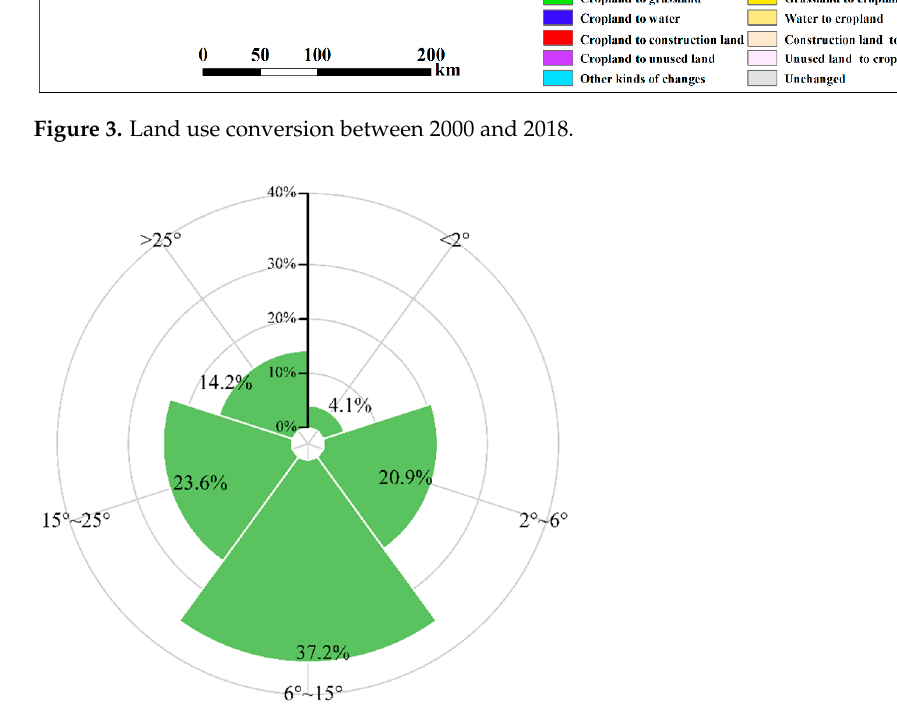
p=0.270y Figure 5. Mean value of NDVI ( a ) and global Moran’s I ( b ) between 2000 and 2018. As 2008 was a key time point for the vegetation change trend, the local Moran’s I of the vegetation was further analyzed for the years 2000, 2008, and 2018. High positive val- ues of the local Moran’s I were mostly concentrated around Wuhan and in the west of Hubei Province (Figure 6a–c), indicating that the NDVI values in these places were similar to those of their neighbors. The areas with a positive local Moran’s I moved to the north- west in Hubei Province during 2000–2018. Meanwhile, negative local Moran’s I values were mainly observed around the Jianghan Plain and became increasingly concentered in the center of Hubei Province. The LISA analysis maps (Figure 6d–f) show that the areas y = 0.0034x − 5.9872 R² = 0.237, p=0.184y = 0.0008x − 0.8282 R² = 0.149,